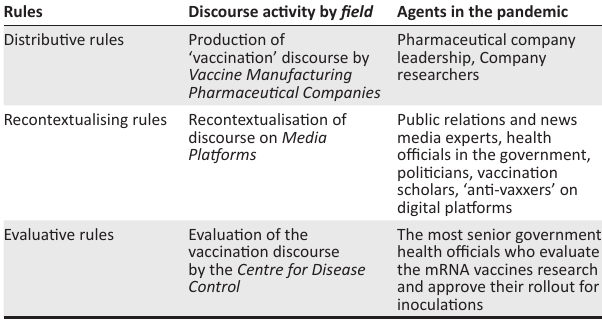
TABLE 3: Division of knowledge labour on mRNA vaccines.